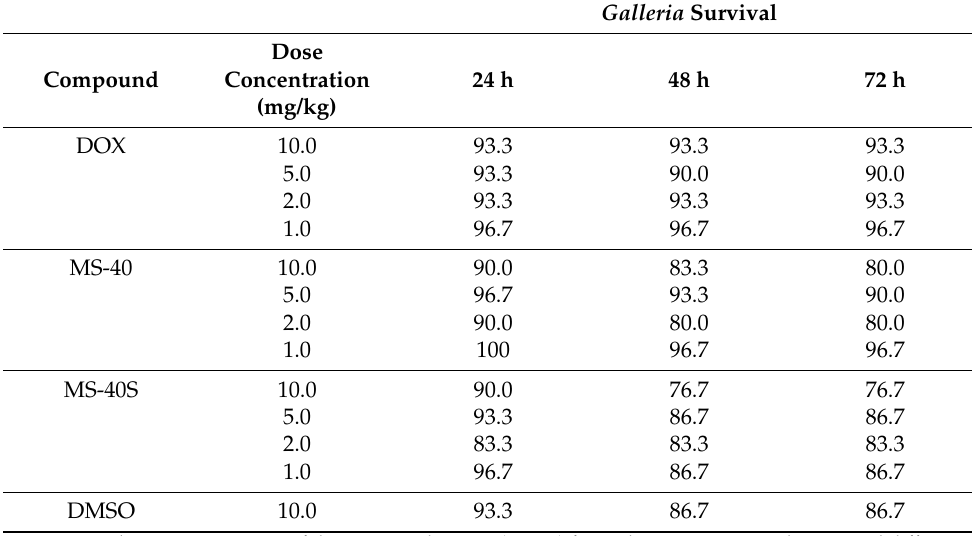
Table 5. Percent survival of Galleria exposed to doxycycline (DOX), MS-40, and